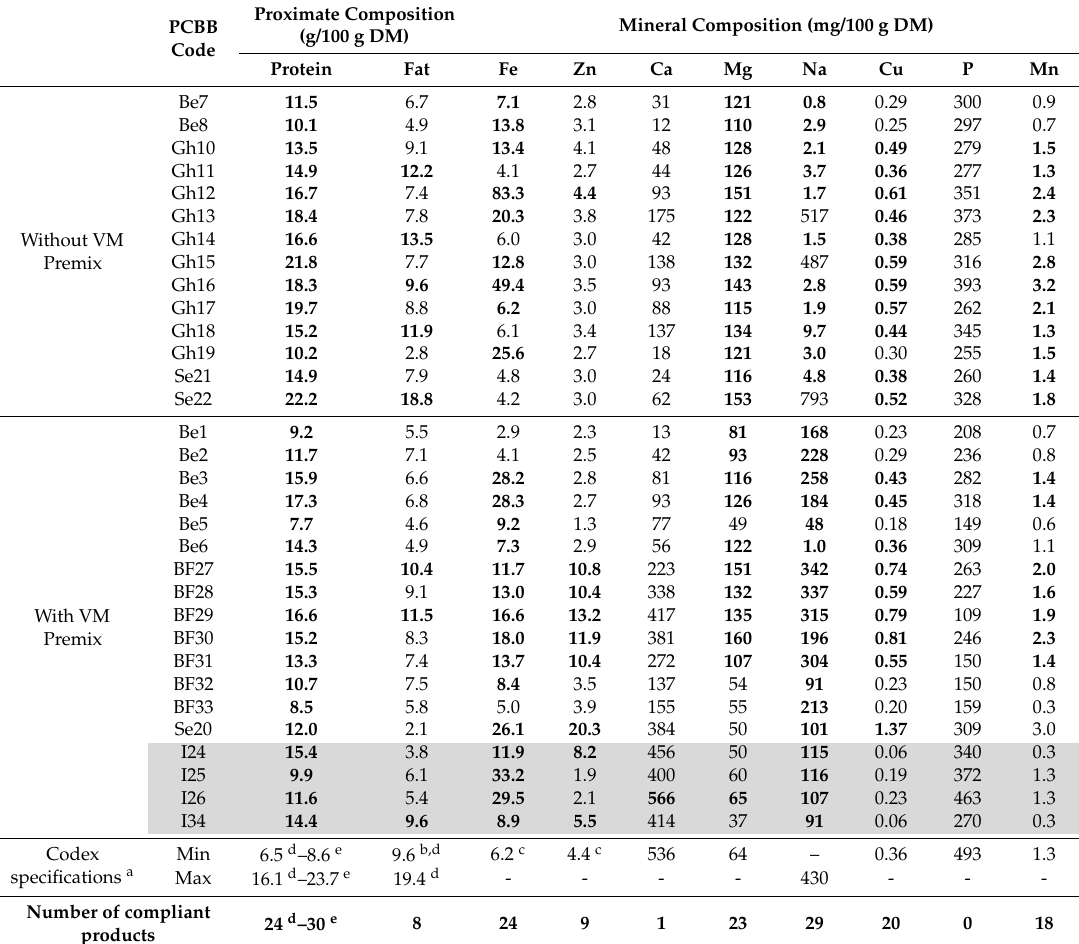
Table 3. Proximate and mineral composition (per 100 g dry matter -DM) of the 32 PCBB